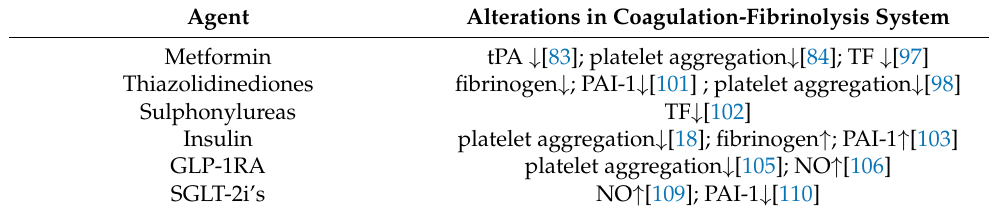
Table 1. Anticoagulation effects of glucose-lowering